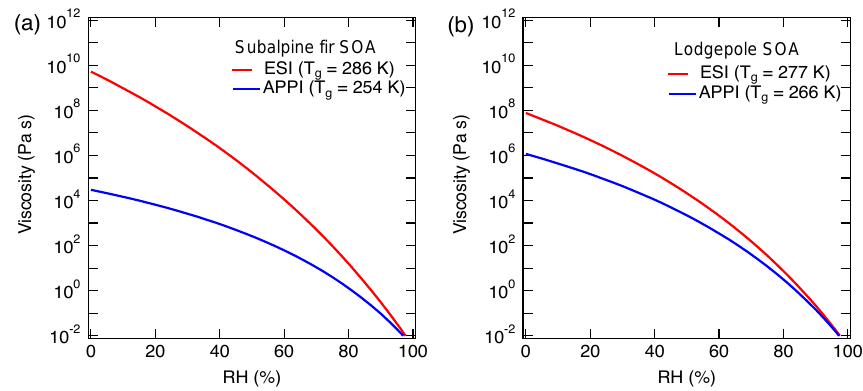
Figure 9. Sensitivity of the predicted viscosity for biomass burning particles of (a) subalpine fir and (b) lodgepole pine trees as measured by high-resolution mass spectrometry to the ionization technique: electrospray ionization (ESI, red) and atmospheric pressure photoionization (APPI; blue). T g , org values are specified in the figure legend and the other parameters used are fixed to κ = 0.1, D = 10, and k GT = 2.5. Different results are obtained for the same sample because ESI and APPI probe a different subset of compounds (Fig.